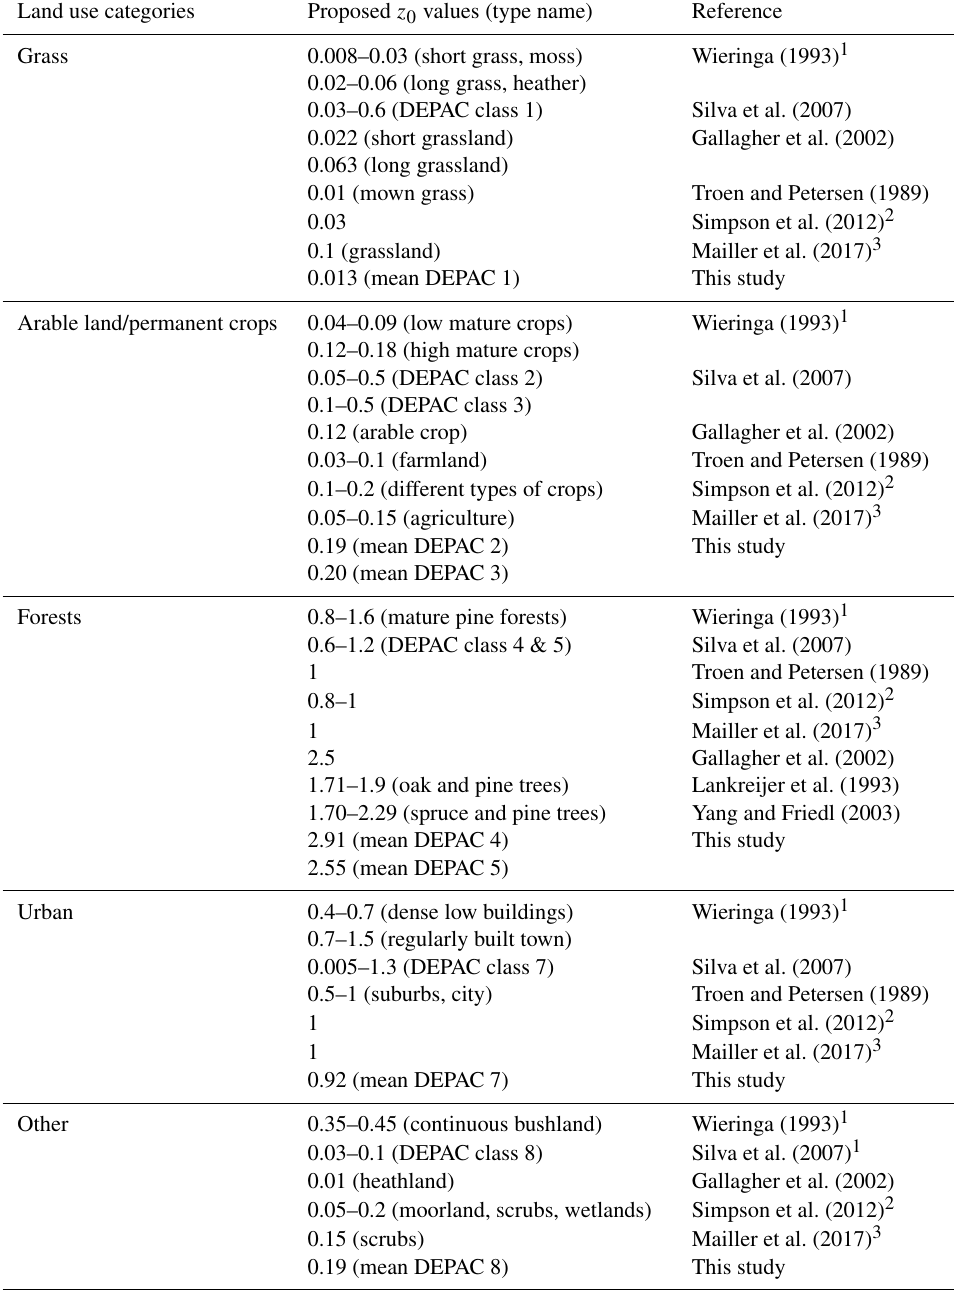
Table 5. Roughness length values from different types of studies. The first column states the global land use category of the z 0 values. The second column states the (range of) z 0 values, as well as the specific type of land use they are derived for. The third column shows